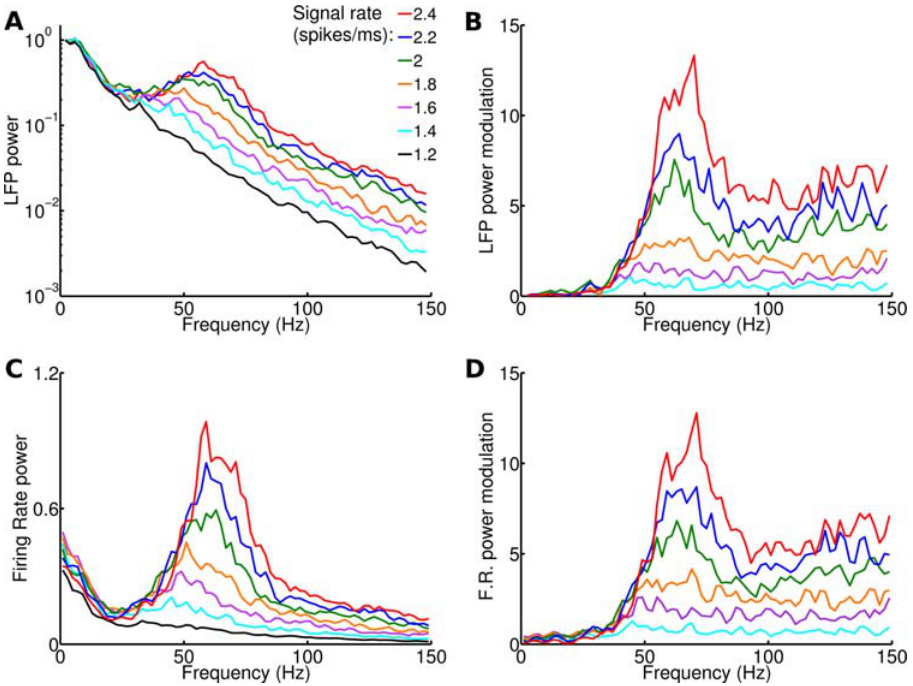
Figure 3. LFP and firing rate power spectrum as a function of signal rate. Each stimulus was composed of a constant signal with a given rate (indicated in the legend) plus noise. Power spectra are averaged from 20 trials of 2 seconds each with different noise realizations. Color code is the same for all panels. (A) LFP power spectrum for various signal rates. (B) Modulation of LFP spectrum for various signal rates. Modulation is defined as the difference of the power of a frequency at a given signal rate and its power at 1.2 spikes/ms signal rate, normalized to the latter power. Compare with Figures 2 and 4 of [8] (C–D) Same as (A–B) for firing rate spectrum. Notice the difference in scale between (A) and (C).